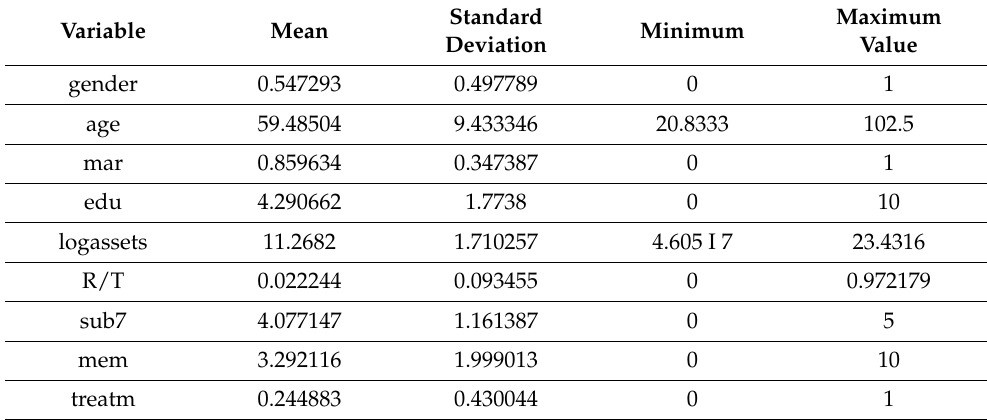
Table 1. Variable descriptive